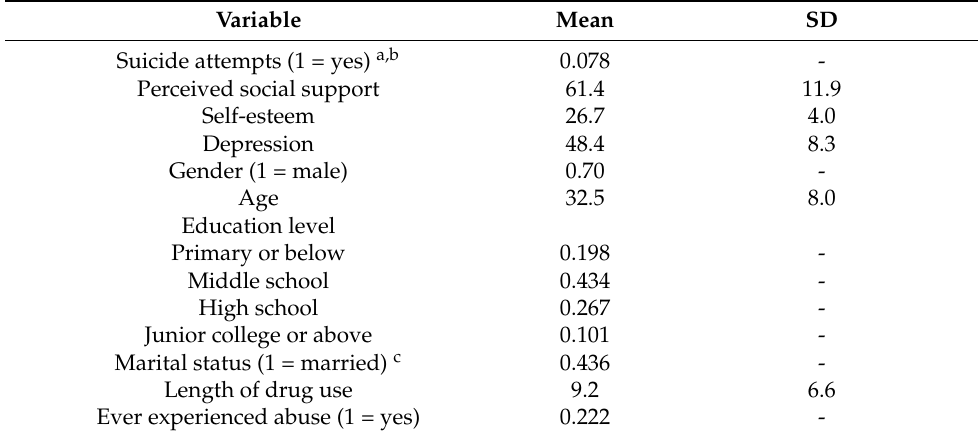
Table 1. Descriptive statistics.